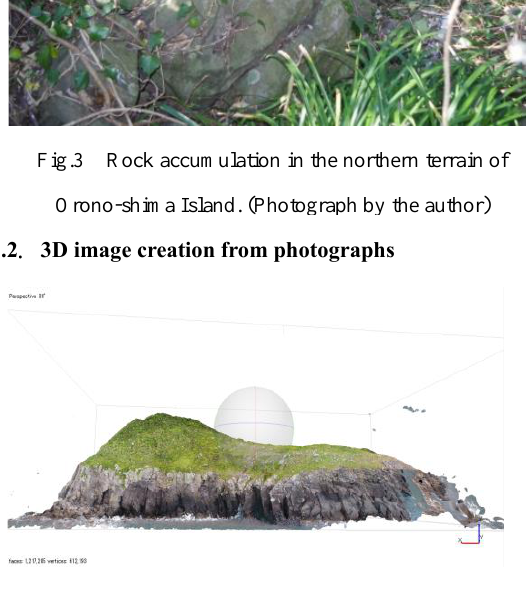
Fig.4 3D image of the northern topography of The Orono- shima Island (from